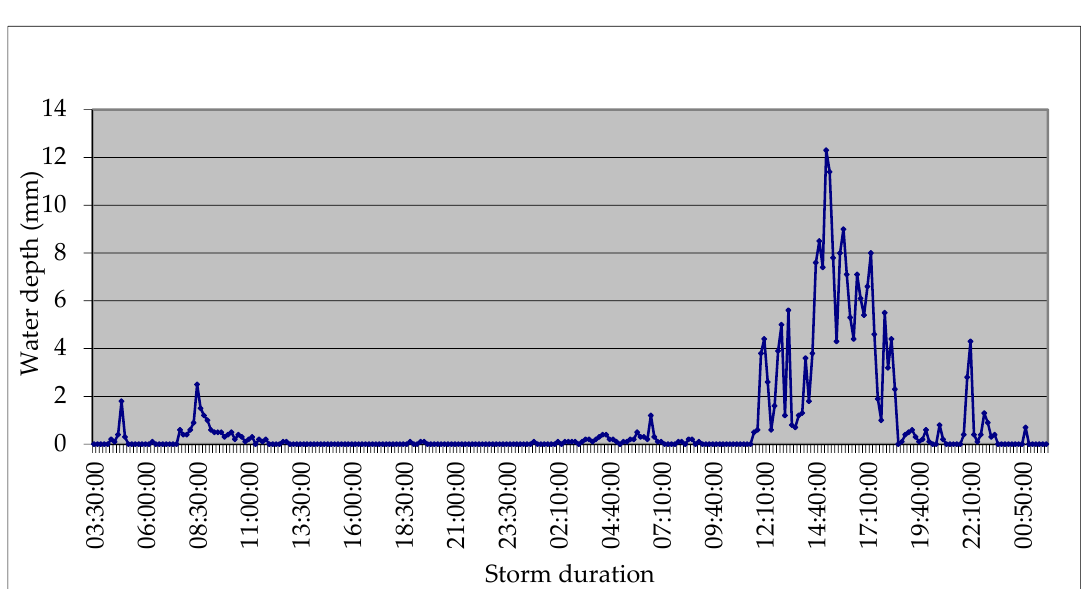
Figure 3. The observed hyetograph for the storm event taking place on the 23 October 2008 in the Melloussa station next to the KALAYA watershed.